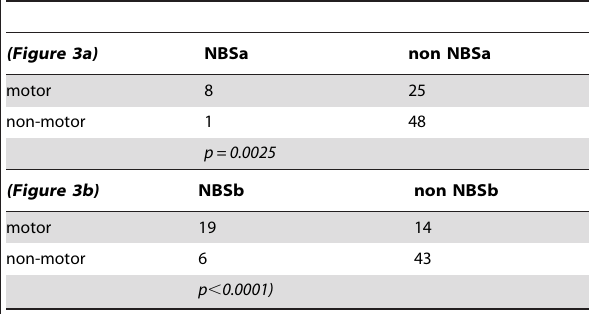
Table 3. Overlap between the impaired sub-network in ALS and the motor network.